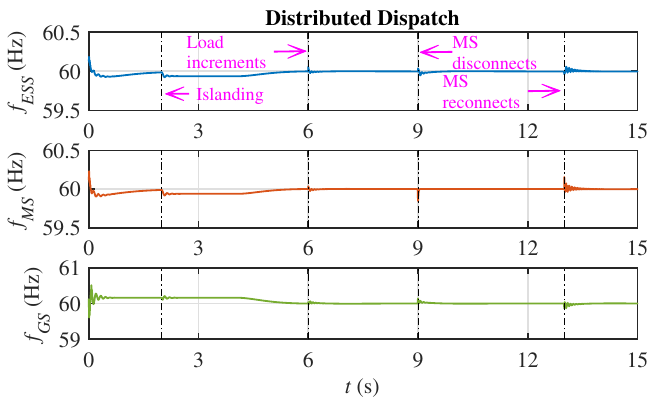
Figure 8. Frequencies of DGUs.